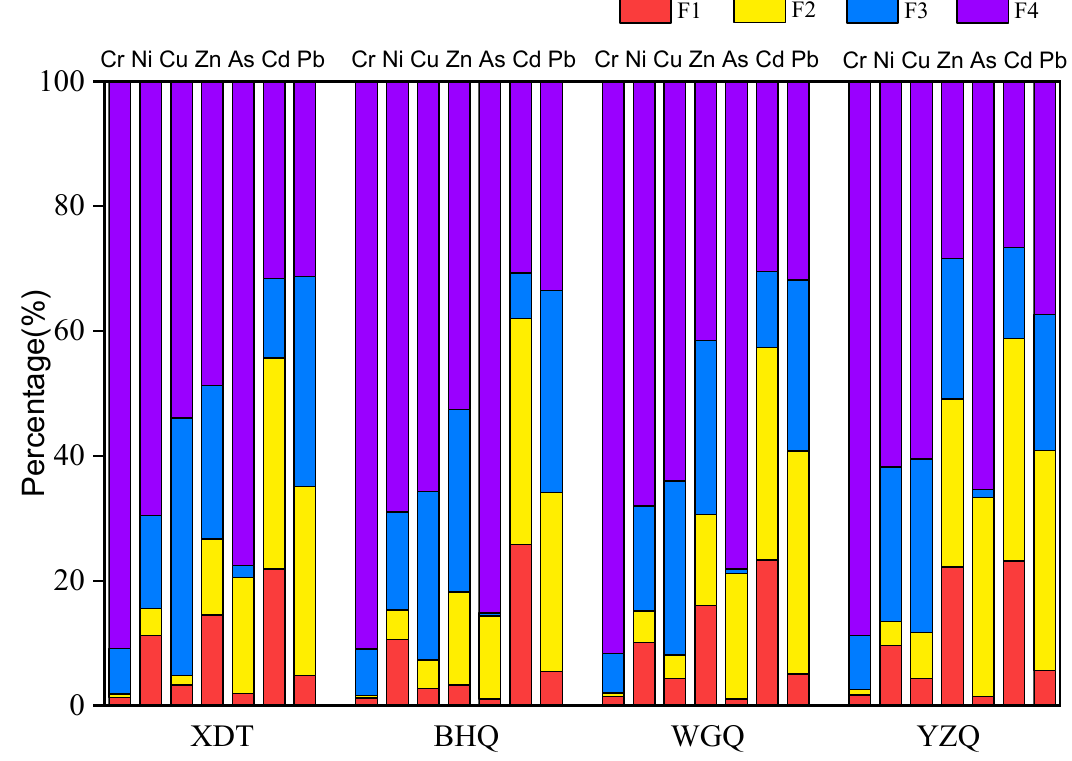
Figure 3. Chemical fractions of PTEs in sediments of the Wuliangsuhai wetland.